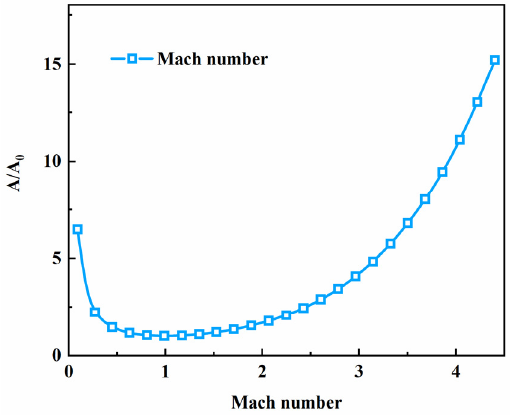
Figure 1. Relationship between the area ratio and Mach number.